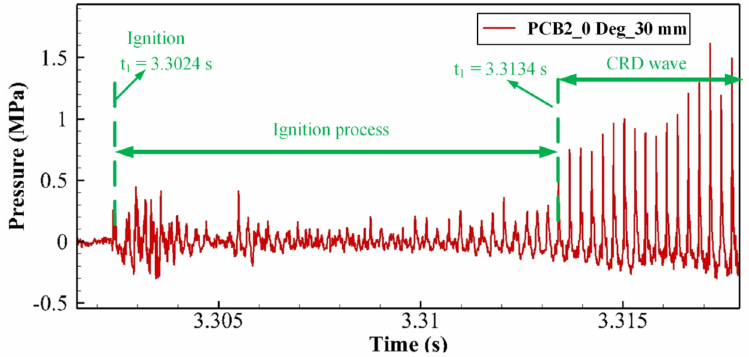
Figure 7. Local view of dynamic high-frequency pressure of Case